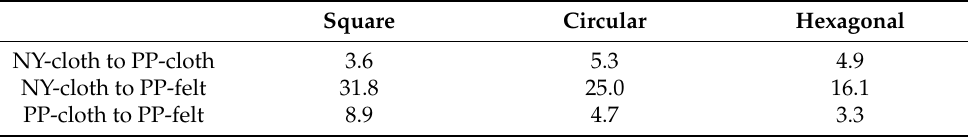
Table 3. Increase of abrasions to rupture of the filter media typical for tailings filtration in comparison with each other for the different edge geometries.